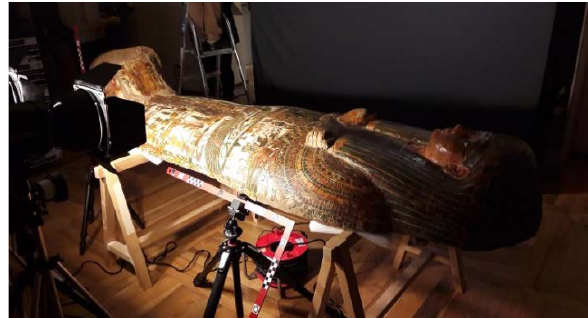
Figure 2. The coffin during the photogrammetric acquisition.